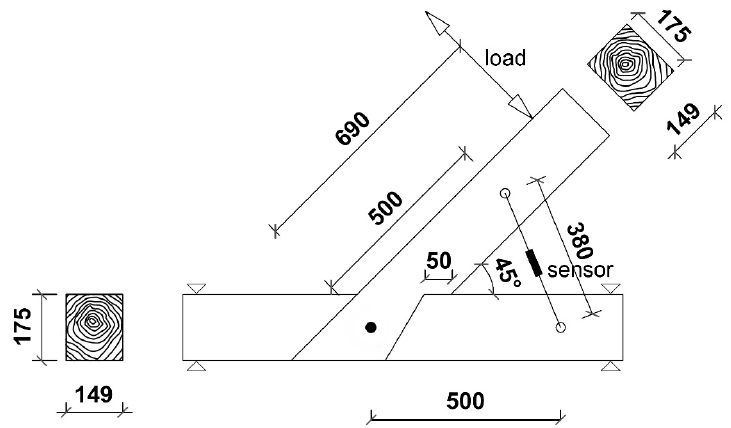
Figure 2. Geometrical scheme of the joint, the potentiometer location and location of the acting force, the direction of the joint’s rotation, and the corresponding